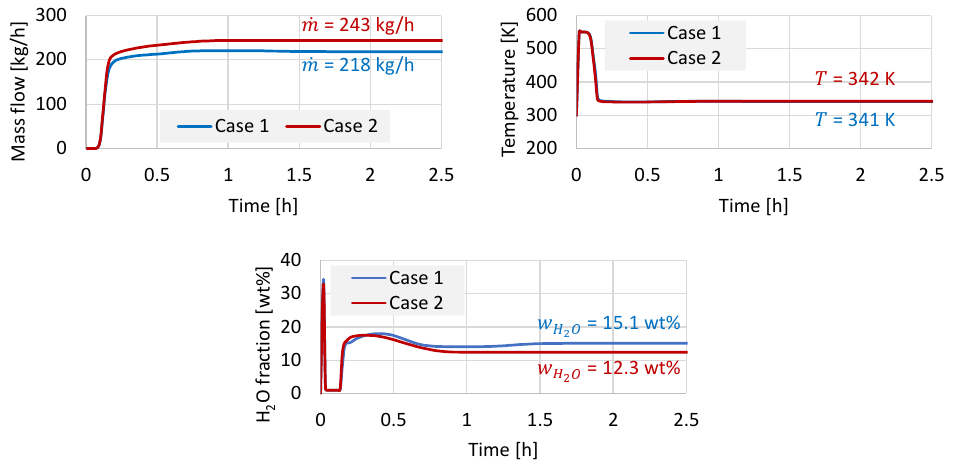
Figure 17. Time-dependent change in mass flow ( top left ), temperature ( top right ), and water content ( bottom ) in the outlet stream of Spray dryer (Spray particles stream in Figure1) for each case study. The organic residues in the solid particles are removed in two serially connected and externally heated rotary kiln stages. In the first kiln, lean air with reduced oxygen concentration is used to limit the maximum temperatures. The gas and solids properties at the respective outlets of the first kiln stage are shown in Figure 18. For both cases, the available oxygen in the lean air is nearly completely used for the combustion. As the inflow of organics, modeled as C, is too large for combustion, the solids still contain their residues. Due to a lower solids flow rate for Case 1, the available oxygen allows for a larger reduction of the organic compounds, leaving 5.7 wt% in comparison to 6.3 wt% of Case 2. However, the larger amount of water in Case 1 leads to slightly lower solids and gas temperatures at the outlet.